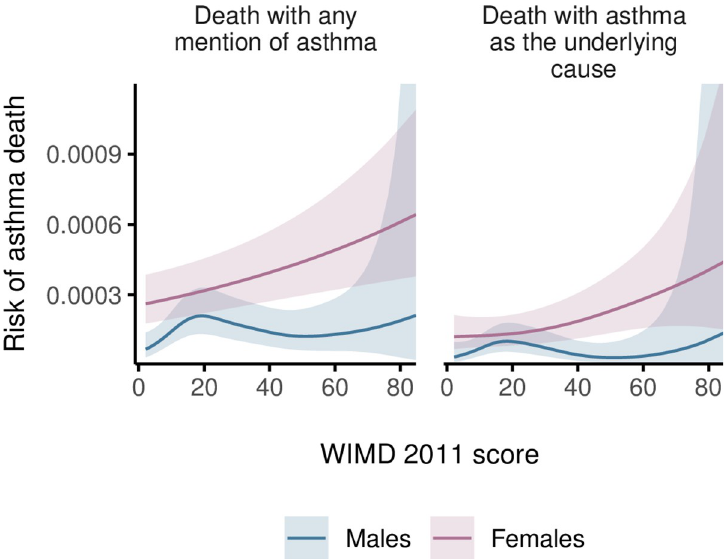
Fig 11. Estimated 5-year risk of asthma deaths for median age in males and females by the WIMD 2011 score. The shaded area represents the 95% CI of risk. CI, confidence interval; Welsh Index of Multiple